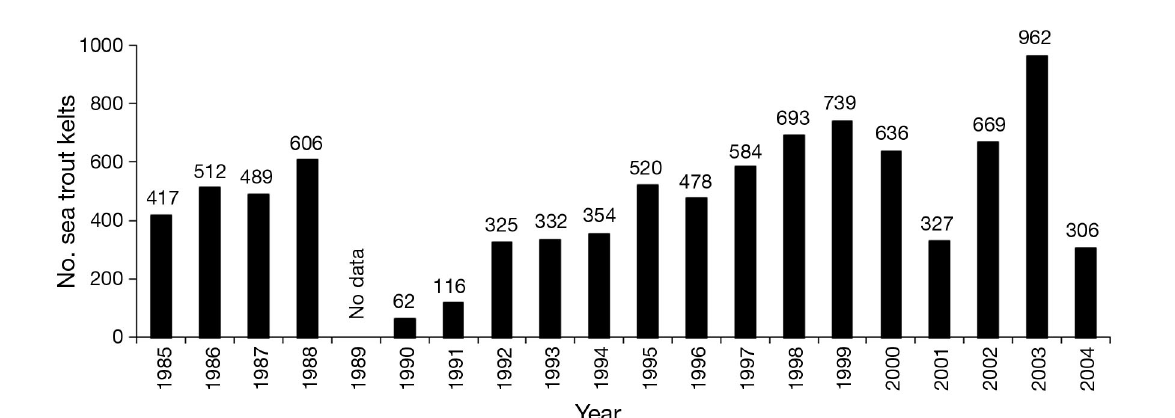
Fig. 4. Annual numbers of sea trout Salmo trutta kelts migrating downstream and captured in the Tawnyard trap between 1985 and 2004